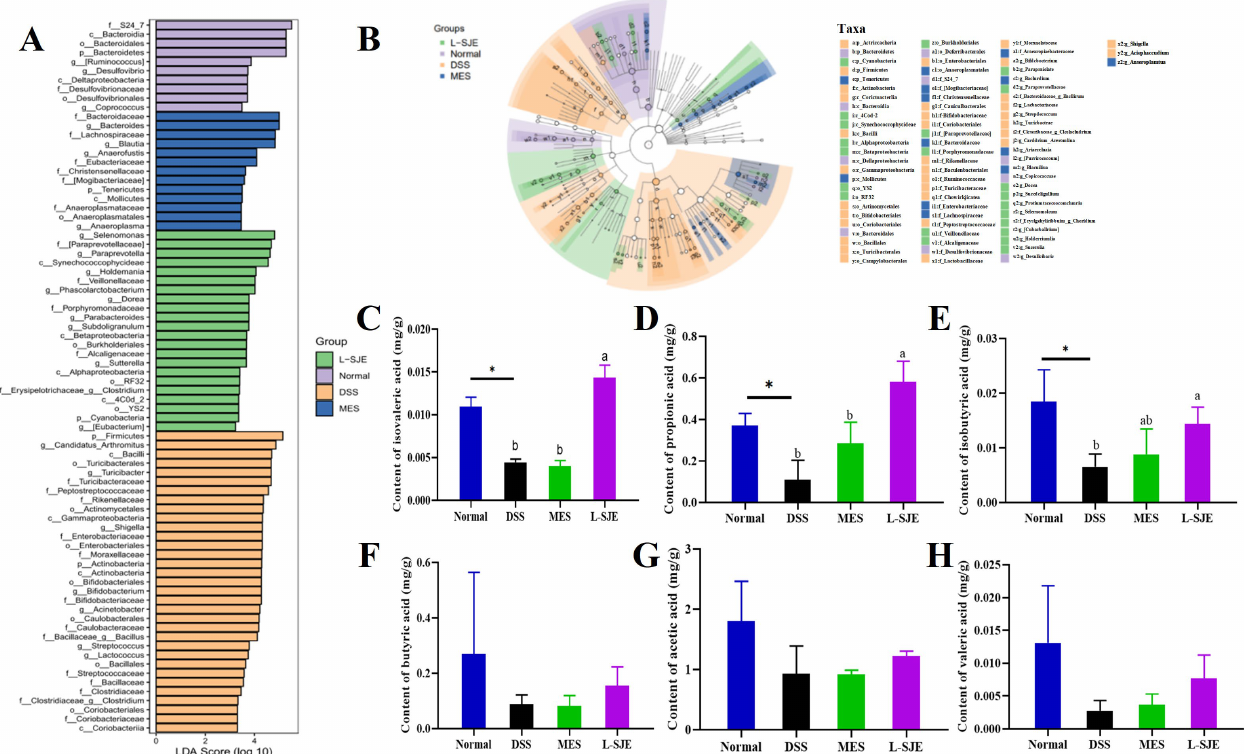
Figure 6. Changes of gut microbiota after different pretreatments and effects of SJE on the produc- tion of SCFAs in feces. ( A ) LDA score. ( B ) LEfSe taxonomic cladogram showed key bacterial altera- tions. ( C ) Content of isovaleric acid, ( D ) propionate acid, ( E ) isobutyric acid, ( F ) butyrate acid, ( G ) acetic acid, and ( H ) valeric acid. * p < 0.05 means statistically significant. Different superscript letters (a,b) in the same graph indicate significant differences between groups ( p <